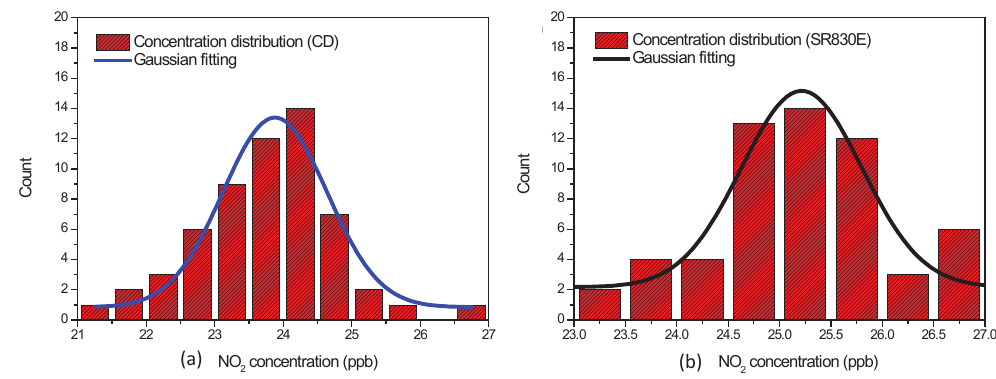
Figure 10. Histogram showing the distribution of the estimated NO 2 concentration (of 24.5 ppbv measured with a reference NOx analyser) by CD ( a ) and SR830E ( b